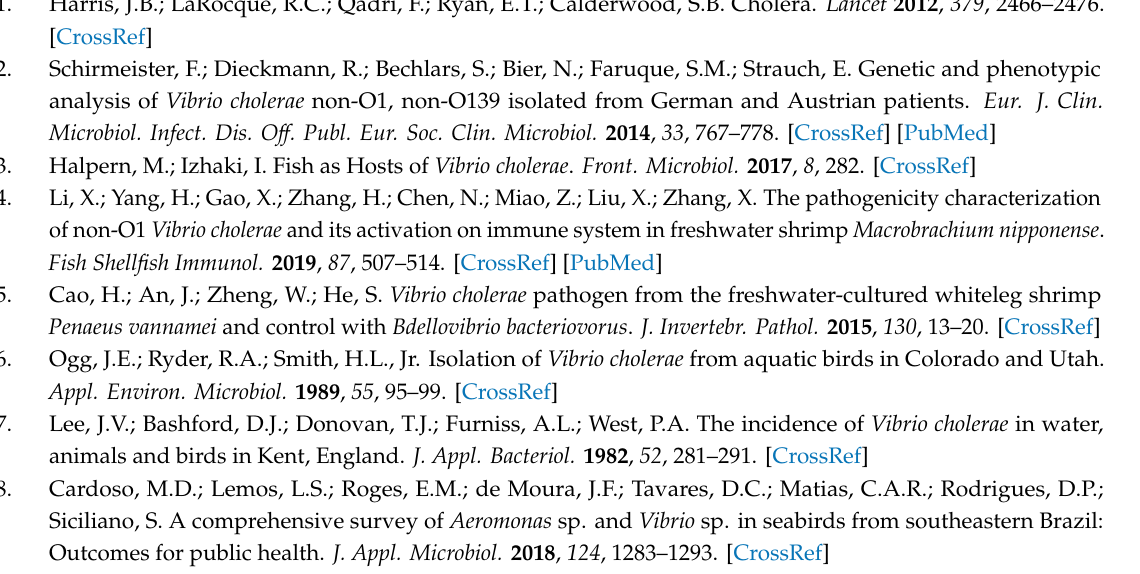
Table S1: AMR of the duck isolates. Table S2: Results of the whole genome sequence. Table S3: SNP distance matrix of V. cholerae non-O1, non-O139